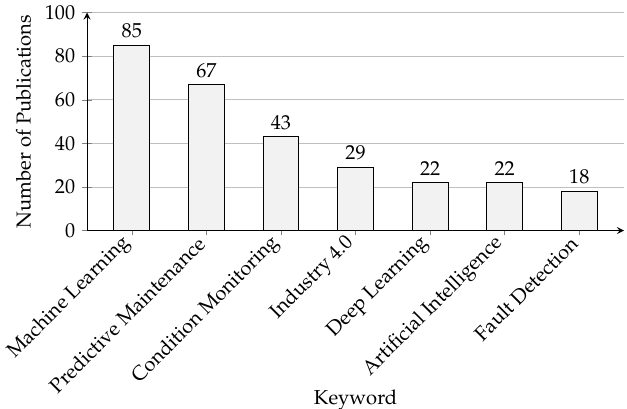
Figure 3. Keyword distribution.